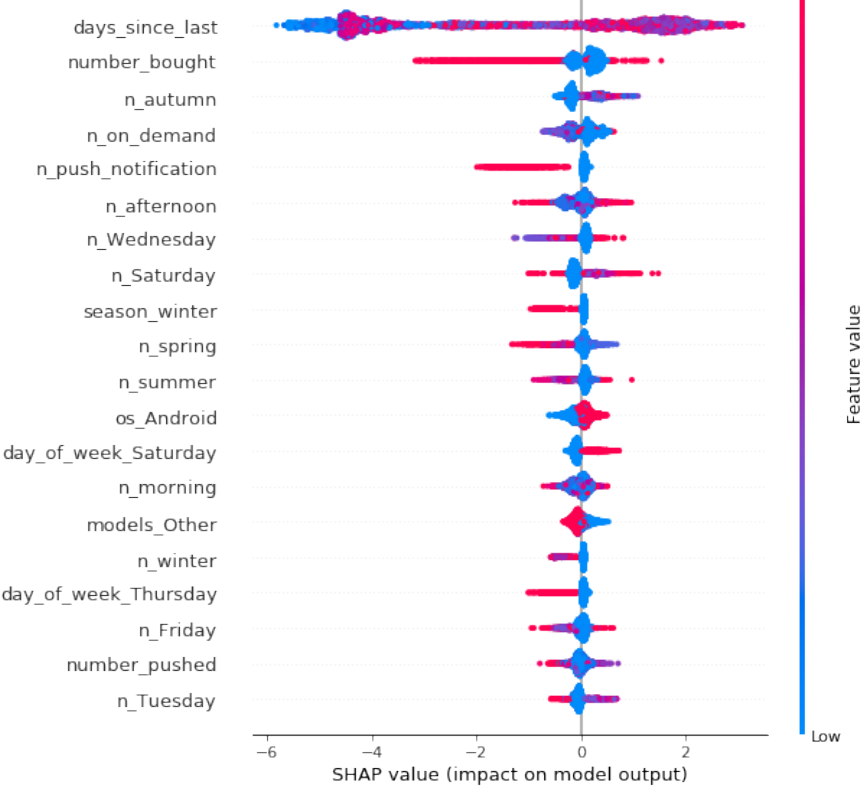
Figure 2. Shapley Additive exPlanation (SHAP) summary